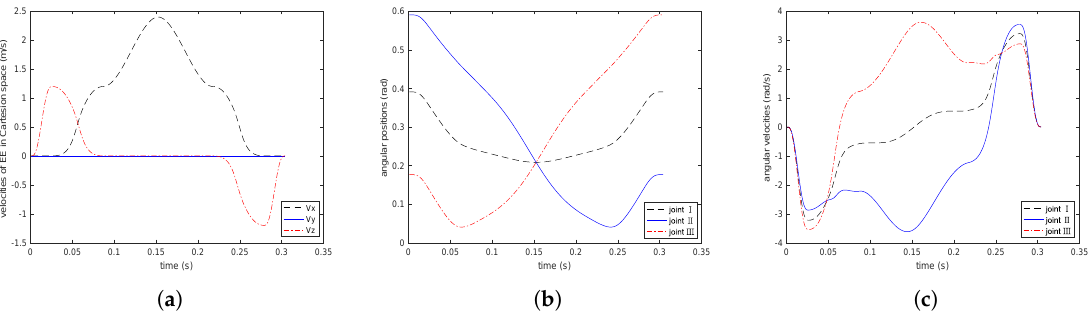
Figure 5. Simulation results of trajectory planning with the proposed method. ( a ) end effector (EE)’s velocities in Cartesian space; ( b ) angular positions; ( c ) angular velocities.